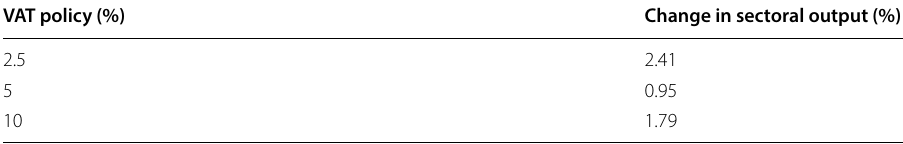
Table 5 Percentage change in sectoral output